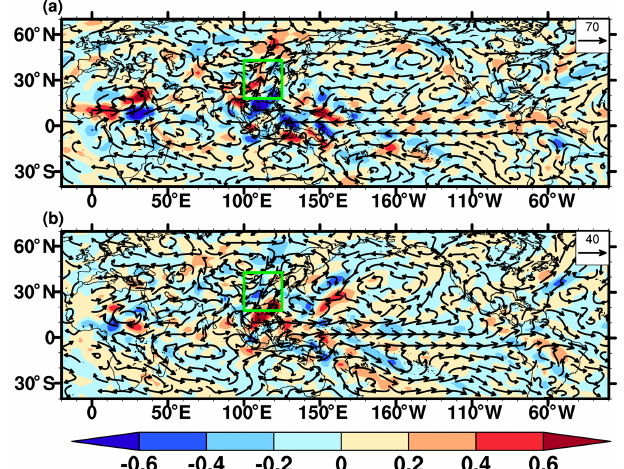
Figure 11. Vertically integrated water vapor anomalies (vector) and water vapor flux divergence (shading) composited from the lightest 25th (a) and highest 75th (b) percentile rainfall events in the wet season. The water vapor flux unit is kgm − 1 s − 1 and for the water vapor flux divergence is kgm − 2 s − 1 . The black rectangle denotes eastern